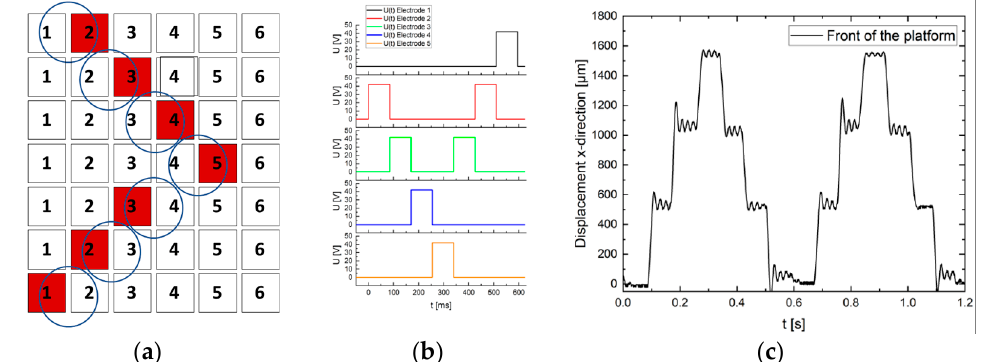
Figure 18. ( a ) Actuation scheme for every liquid bearing. Five control electrodes were switched on (red) sequentially for 85 ms at 42 V;( b ) voltage input timing sequence.. First period guaranteed a stable initial position of the moving platform. ( c ) Platform displacement in x -direction. Displacement was measured at the front side of the platform (cf. Figure 19).